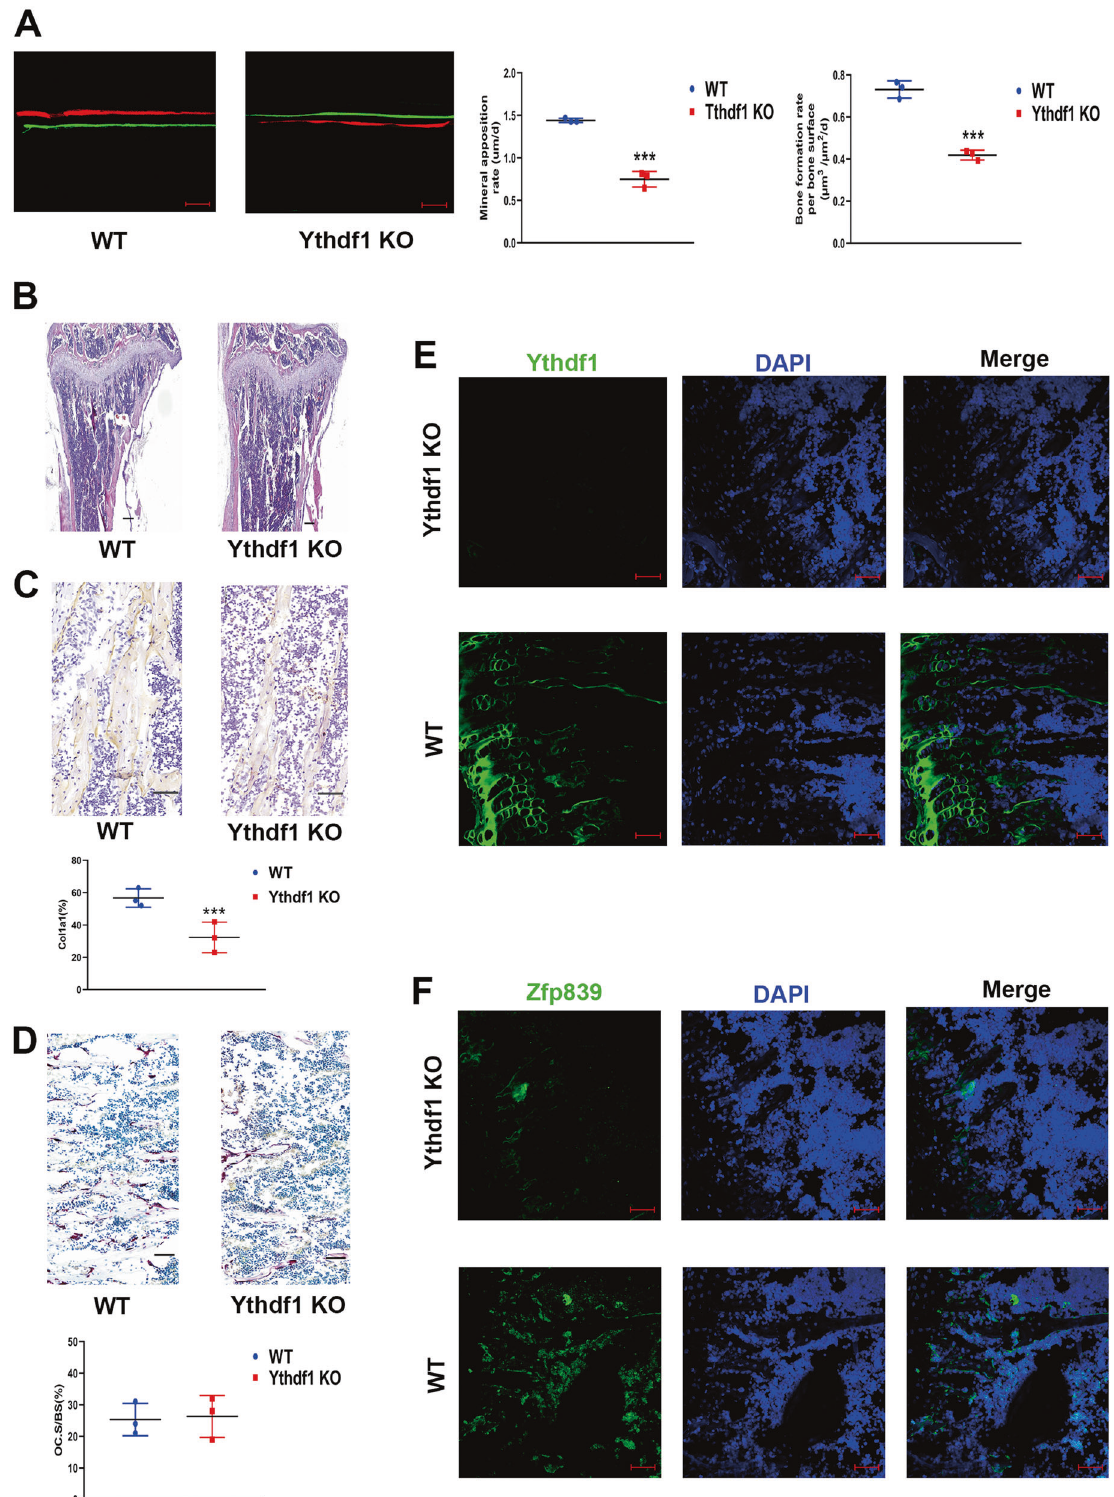
Fig. 6 Ythdf1 potentiates osteoblast differentiation in vivo. A Representative images of calcein and Alizarin Red S-labeled bone formation with MAR and BFR/BS analysis in WT and Ythdf1 KO mice; scale bar = 50 µm. Quanti fi cation analysis was performed using ImageJ software. ( n = 3), ***P < 0.01. B H&E staining of the murine tibia from 3-month-old male WT and Ythdf1 KO mice. Scale bar = 200 µm. C Immunohistochemical staining of Col1a1 in proximal tibia metaphysis from WT and Ythdf1 KO mice. Scale bar = 20 µm. Quanti fi cation analysis was performed using ImageJ software. ( n = 3), ***P < 0.01. D Representative TRAP staining images of the metaphysis and quantitative analysis of the ratio of OC surface to bone surface (OC.S/BS) from WT and Ythdf1 KO mice. scale bar = 50 µm. E , F Ythdf1 and Zfp839 expression detected by immuno fl uorescent assays in both groups; scale bar = 50 µm.